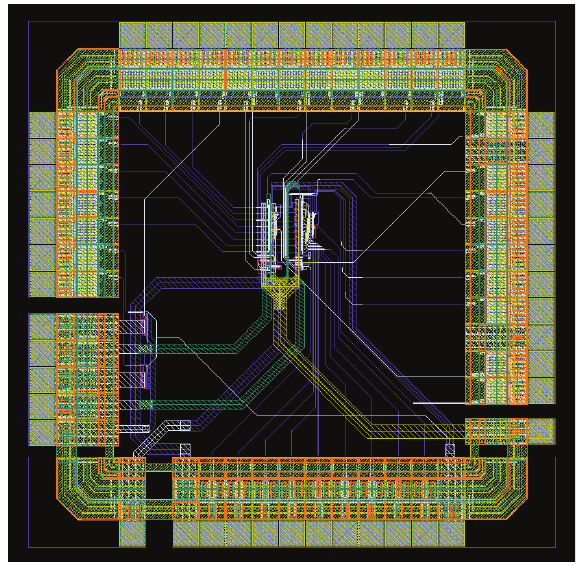
Figure 19: Implemented chip in 0.35 μ m CMOS technology combined with the MTJ-TAS magnetic